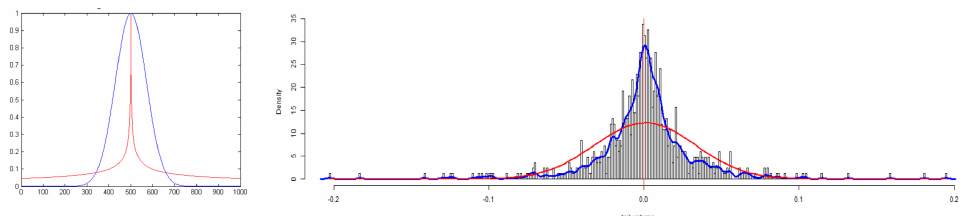
Figure 6. Left: Comparison of a Lévy distribution (red) for γ < 2 when p ( x ) ∼ 1/ | x | 1 + γ with a standard Gaussian distribution (blue) when γ = 2. Right: Comparison of a Gaussian distribution with the distribution for price changes of a Cryptocurrency (Bitcoin–USD exchange rates). The Figure on the right hand side illustrates the incompatibility of the distribution for price changes (grey bars and blue line) with a normal distribution (red line) and its similarity with a Lévy distribution which is peaked at the centre and has significant bars in the tail